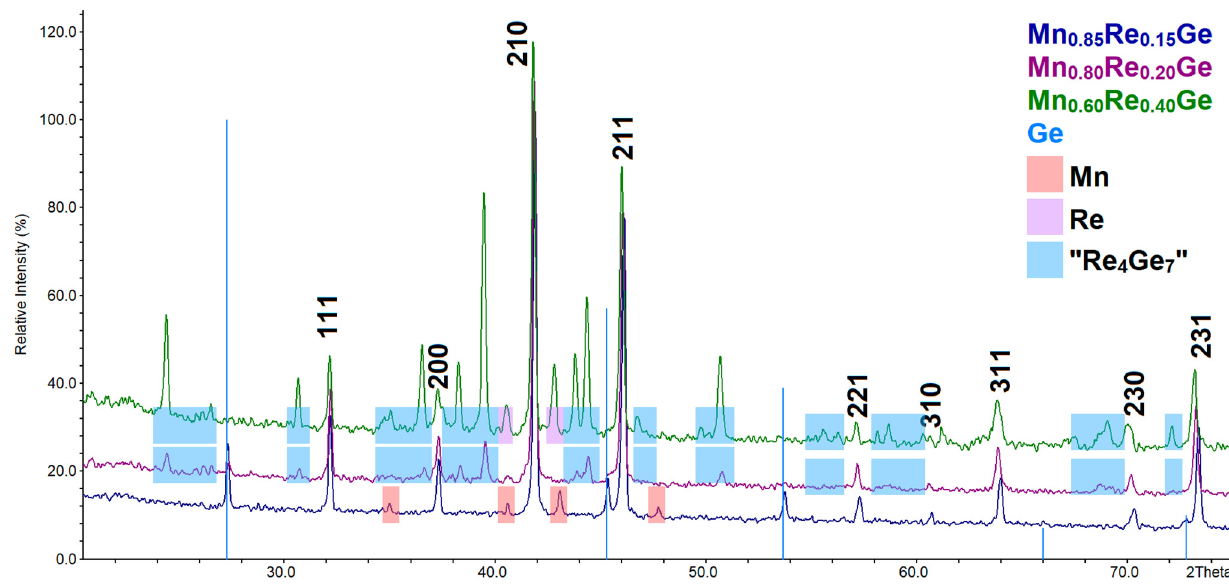
Figure 3. PXRD patterns of the Mn 1 − x Re x Ge polycrystalline samples with nominal x = 0.15, 0.20, and 0.40.